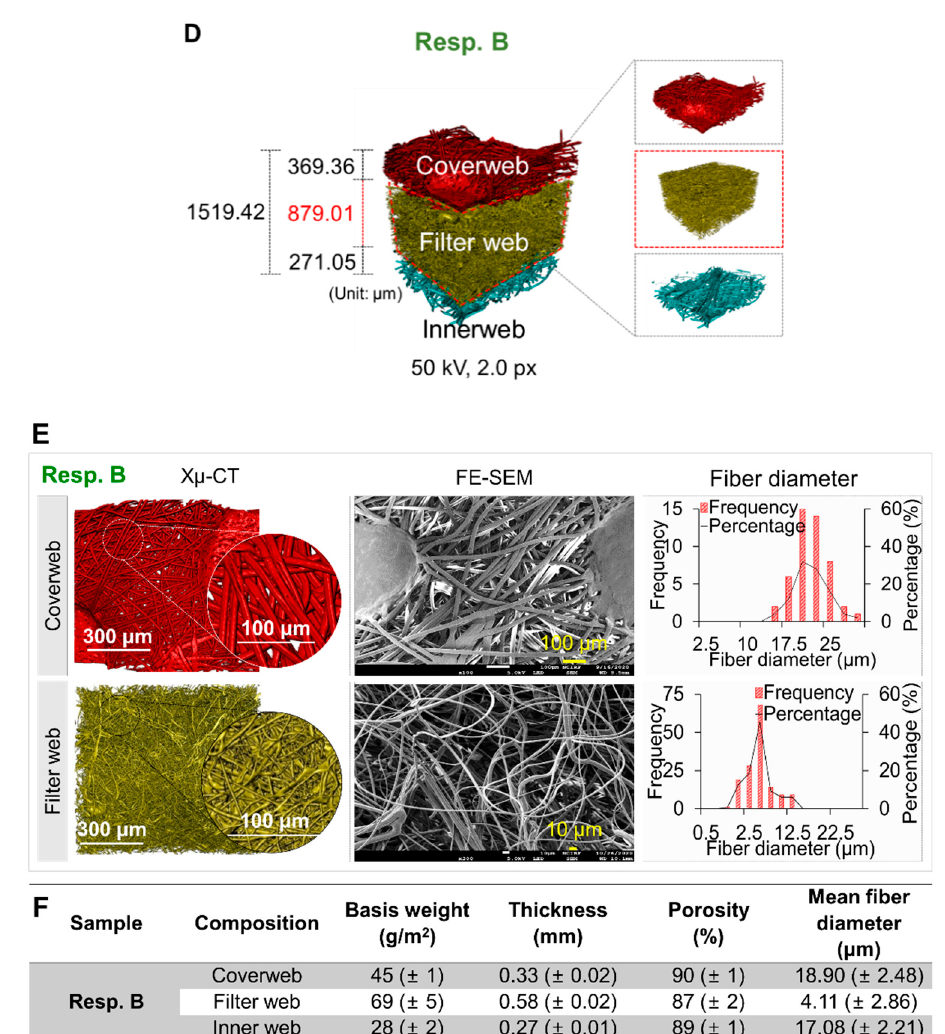
Figure 1. ( A , D ) Layer structures of respirators visualized by X-ray computed tomography (X µ -CT), ( B , E ) 2D images and fiber diameter distribution using X µ -CT and FE-SEM, and ( C , F ) morphological parameters of respirator components. The fiber diameter distribution is suggested in frequency and percentage, indicated as the red bar graph and black line, respectively.